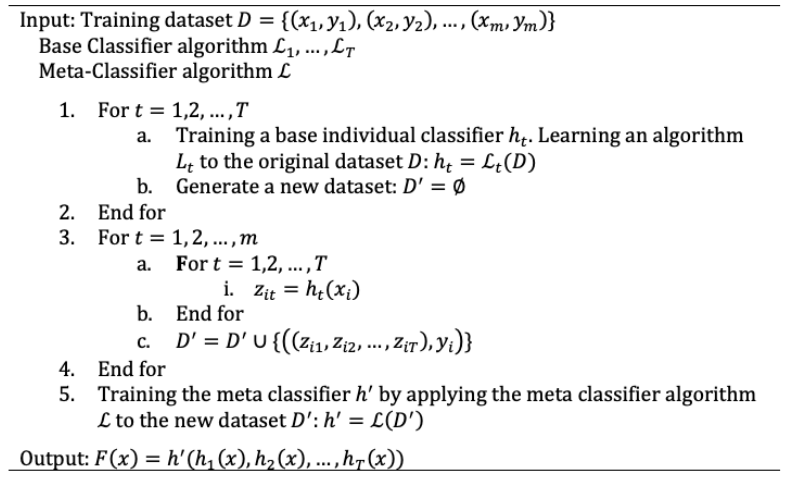
Figure 3. The algorithm for the proposed approach